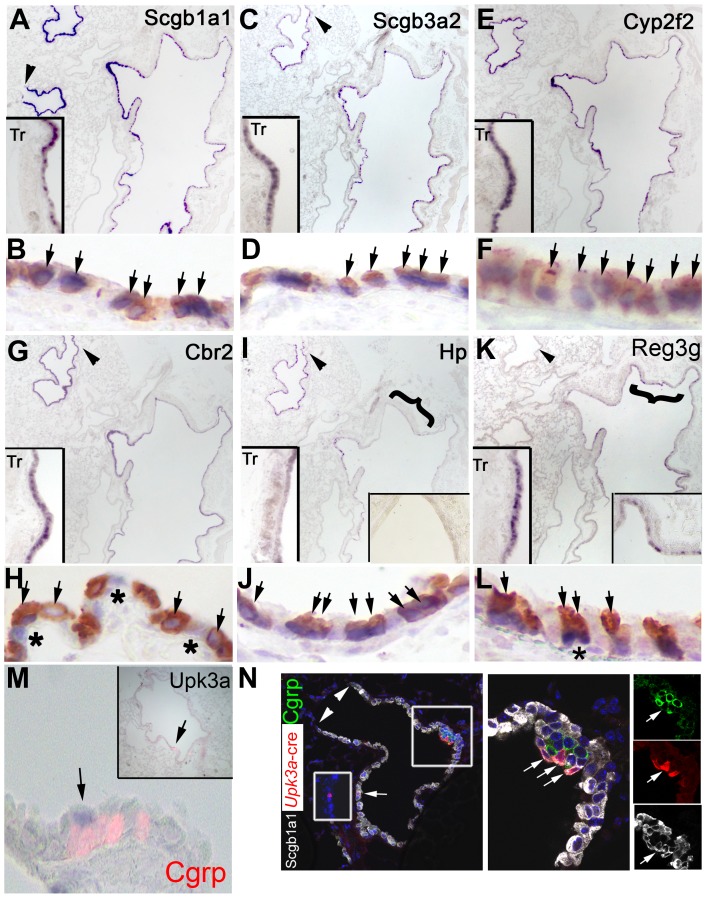
Several genes downregulated in RbpjkCNULL at E18.5 are expressed in adult CCs.
(A–H) Transcripts that were broadly expressed from trachea to terminal bronchiole (arrowhead) in cells that expressed Scgb1a1 (B, D, F, H, arrows, brown = Scgb1a1 protein). Cbr2 was expressed along the entire airway both, in cells that express Scgb1a1 (H, arrows) and others (H, asterisks). (I–N) Transcripts that were expressed in restricted patterns in the airways in cells that expressed Scgb1a1. Hp expression was negligible in the trachea (I, left inset) and mainstem bronchi (bracketed region shown at higher resolution in right inset) but high in the terminal bronchiole (I, arrowhead). Hp expressing cells in the intrapulmonary airways co-expressed Scgb1a1 (J, arrows). Reg3g expression detected in the trachea (K, left inset) and mainstem bronchi (bracketed region shown at higher resolution in right inset) but not in the terminal bronchiole (K, arrowhead). Many Reg3g expressing cells in the proximal airways co-localized with Scgb1a1 and a few cells did not (L, asterisk). Upk3a expressing cells were rare (M, arrow) and only detected in the vicinity of NEBs (Cgrp, red). (N) Upk3a-creER expressing cells were distributed throughout the intrapulmonary airways (arrowheads mark the bronchioalveolar duct junction). Upk3a-creER expressing cells in the adult lung (red, arrows) were clustered around NEBS (green) and expressed Scgb1a1 (white).